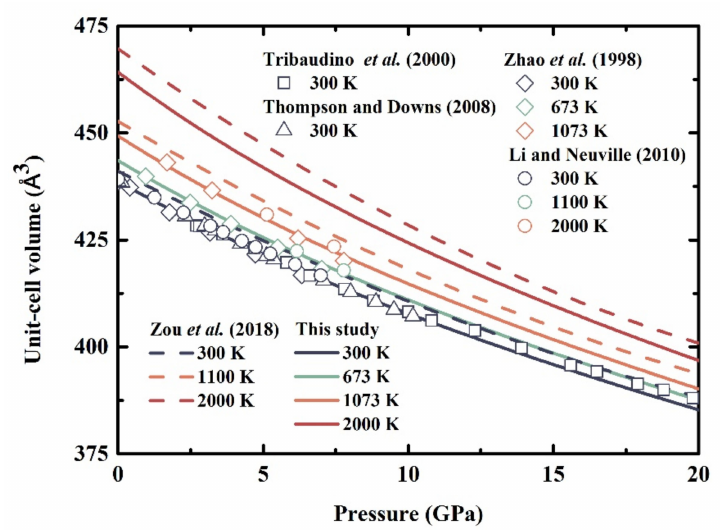
Figure 1. Unit-cell volume of diopside as a function of pressure at various temperatures. Solid lines refer to our calculated results, and dashed lines refer to the first-principle calculation results from Zou et al. (2018) [24]. The squares and triangles represent the measurements at 300 K by Tribaudino et al. (2000) [43] and Thompson and Downs (2008) [42], respectively. The diamonds and circles correspond to the measurements at various temperatures by Zhao et al. (1998) [25] and Li and Neuville (2010) [23], respectively.